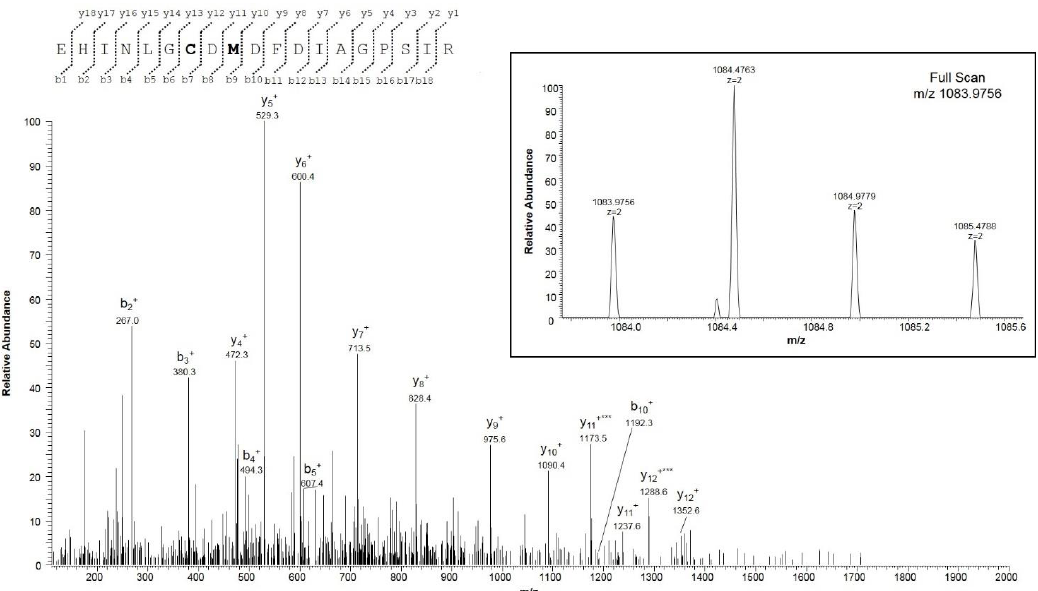
Figure 2. MS/MS spectrum of the doubly charged molecular ion at m/z 1083.9756 (calculated 1083.9754) of the VDAC1 tryptic peptide from HAP1 cells containing cysteine residue 127 in the form of sulfonic acid and methionine residue 129 in the oxidized form of methionine sulfoxide. The inset shows the full scan mass spectrum of molecular ion. Fragment ions originated from the neutral loss of methanesulfenic acid (CH 2 SOH, 64 Da) are indicated by three asterisks.